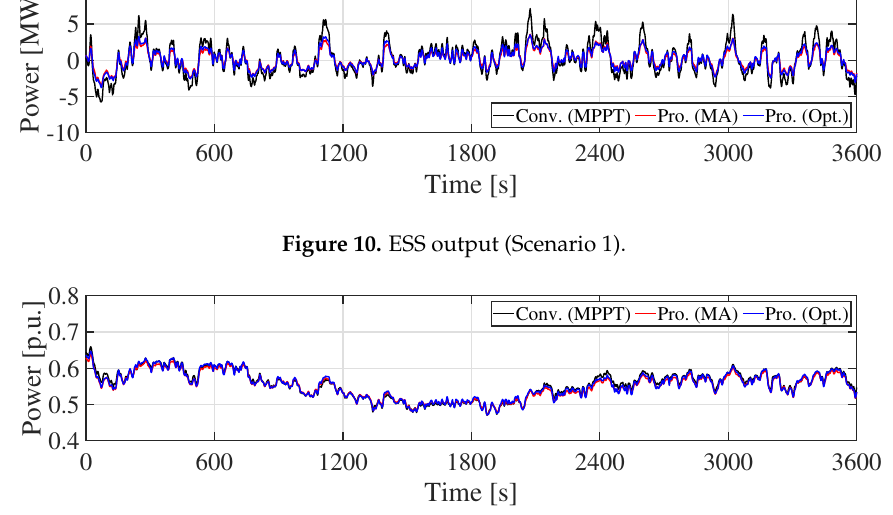
Figure 11. Combined output (Scenario